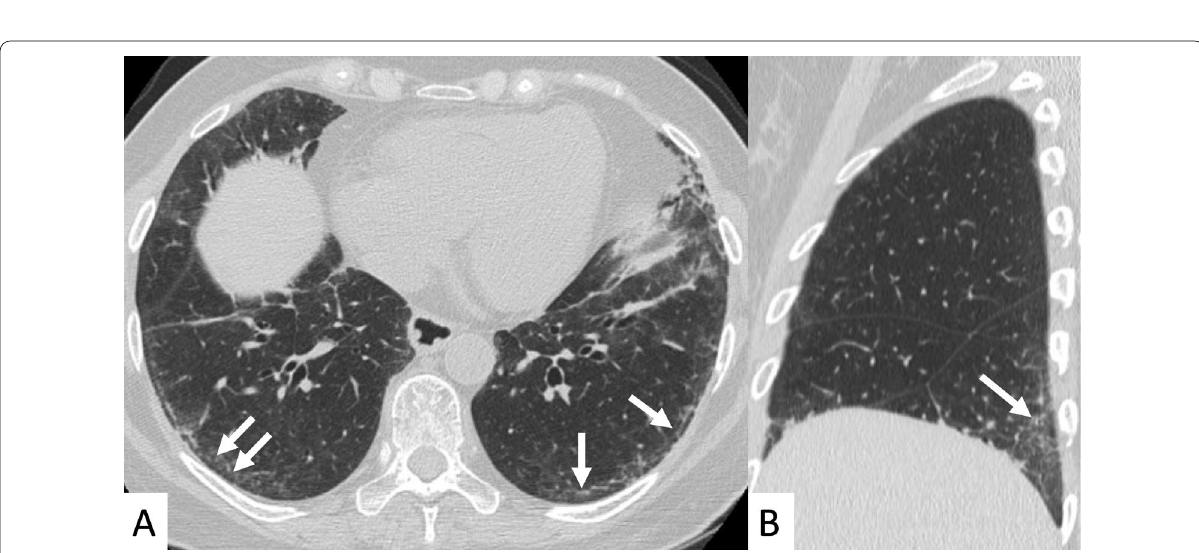
Fig. 10 NSIP pattern with subpleural sparing in a female SSc patient. Axial ( A ) and sagittal ( B ) HRCT images demonstrate ground-glass opacities predominantly located in the basal pulmonary regions, with peripheral and subpleural distribution (white arrows). Pulmonary alterations may